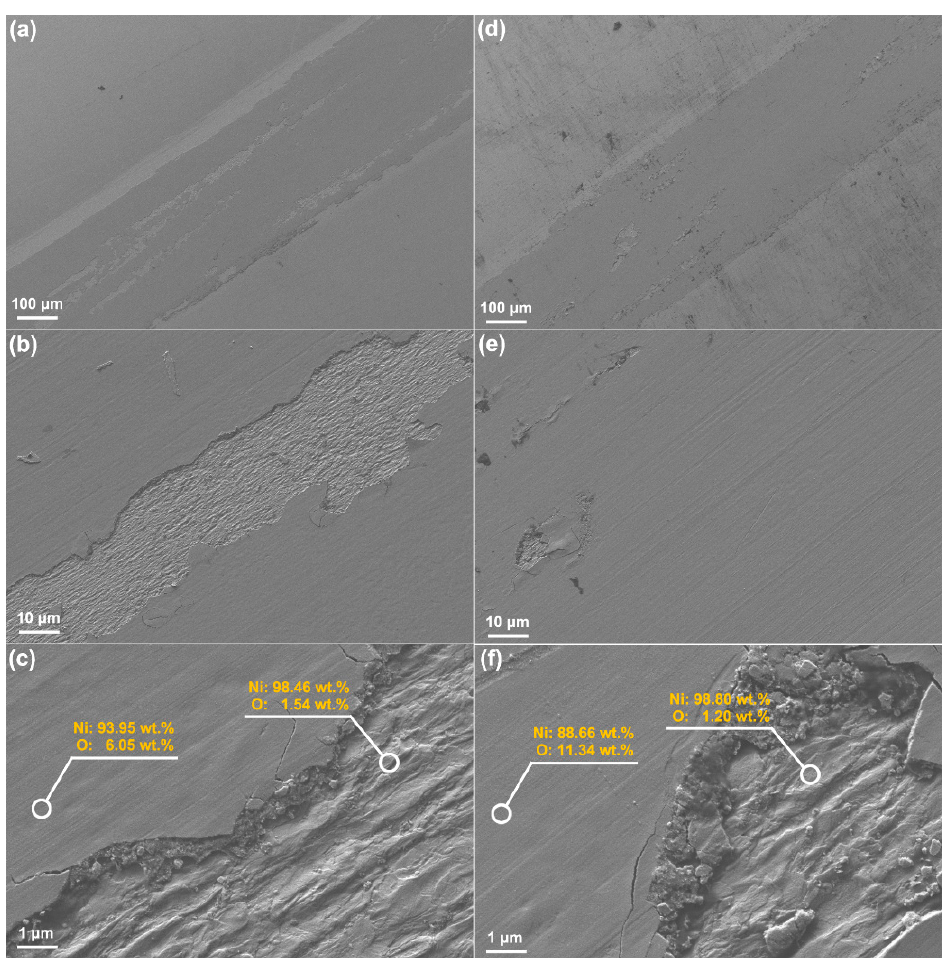
Figure 6. The SEM images of Ni after the potentiostatic tribocorrosion tests with different applied potentials: ( a – c ) 200 mV, ( d – f ) 400 mV; the EDS results were inserted in the images.